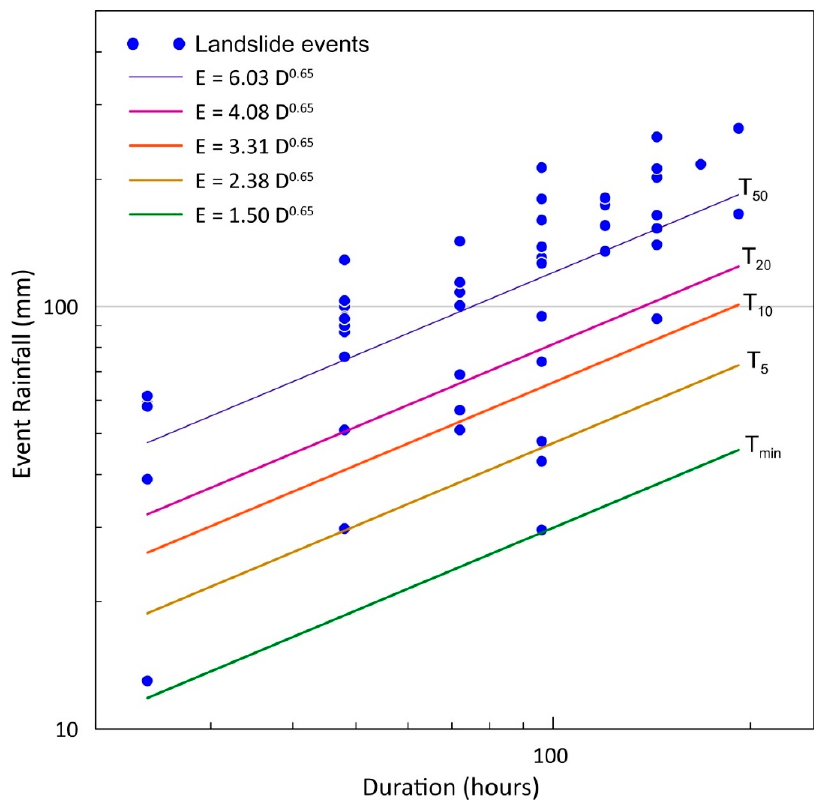
Figure 5. Event–duration thresholds using frequentist approach on logarithmic plot.